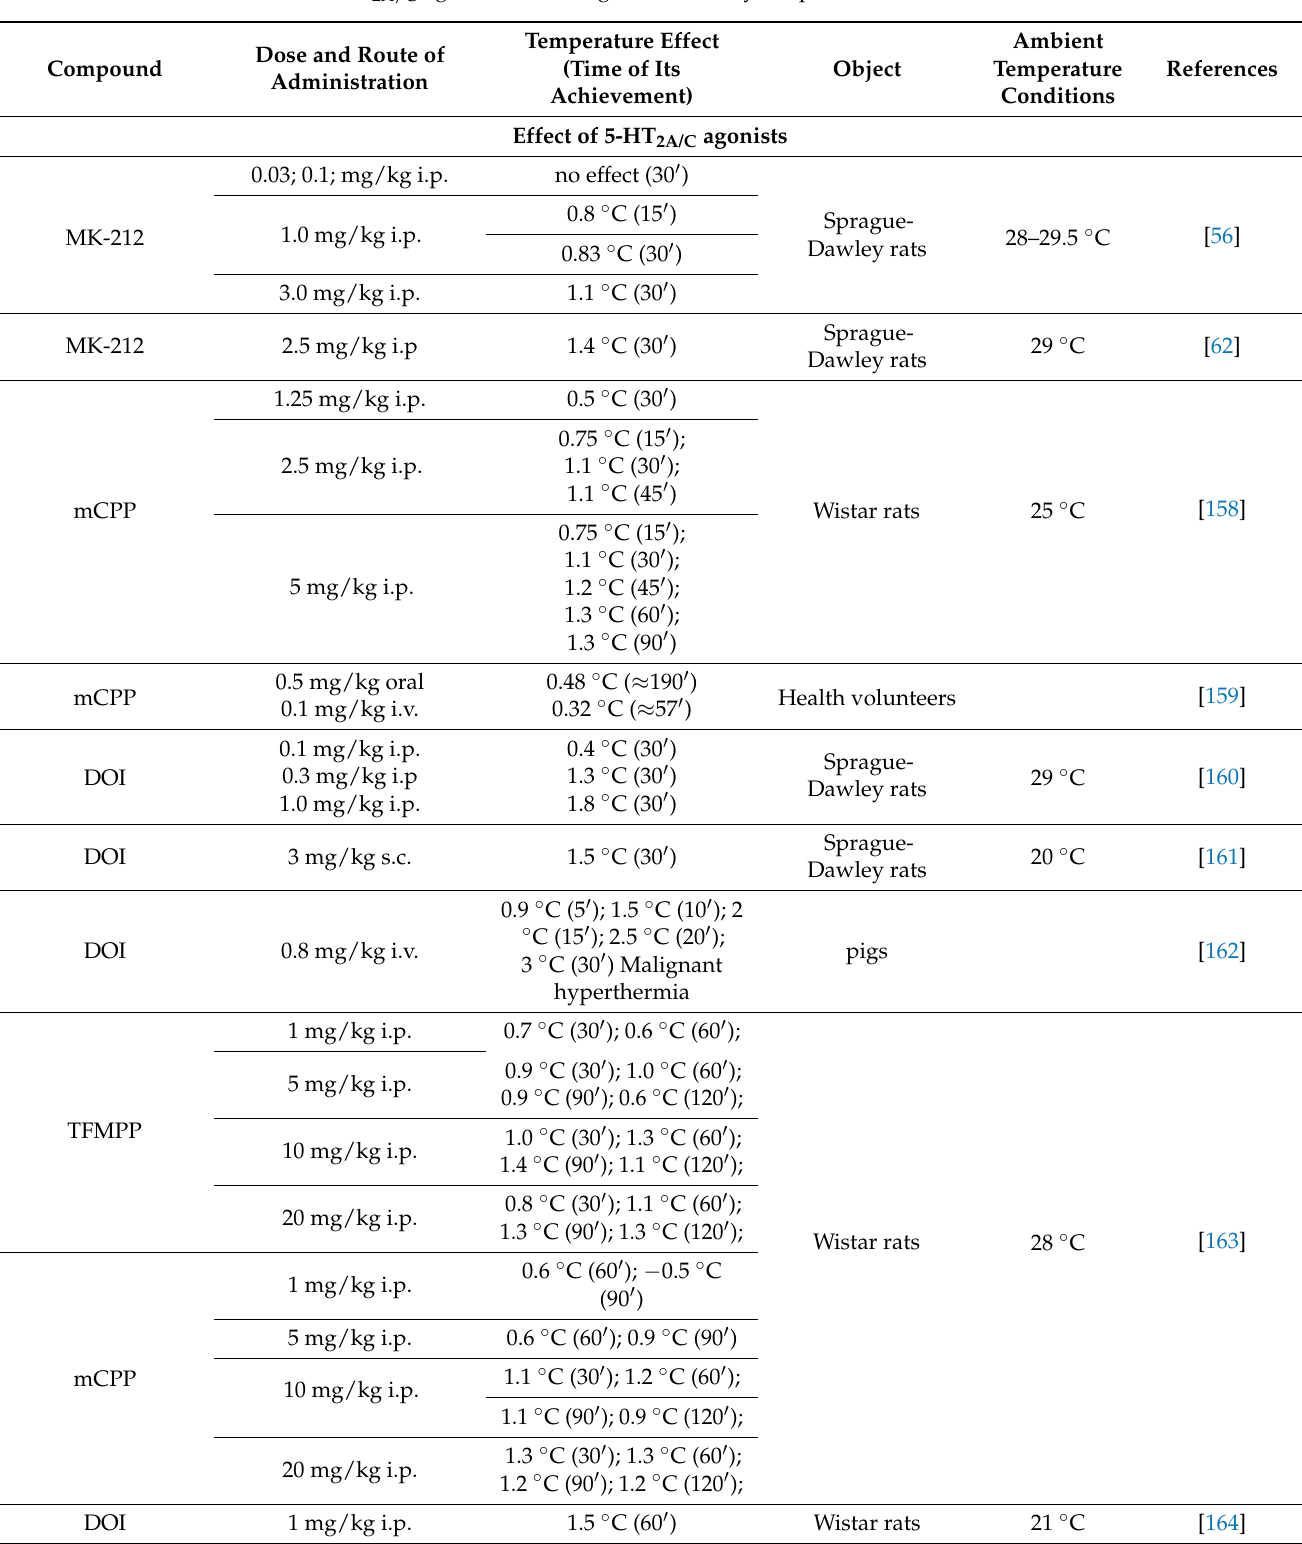
Table 4. Effect of 5-HT 2A/C agonists and antagonists on body temperature of warm-blooded animals.